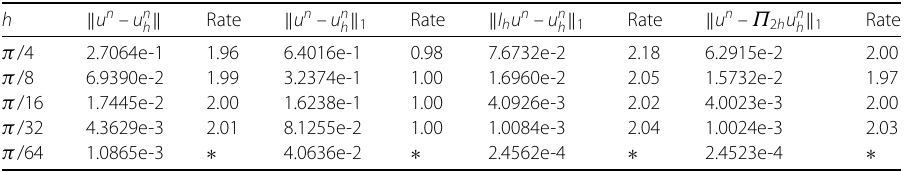
Table 6 Numerical errors and convergence orders in spatial direction with τ = 1 α = 0.3 at T = 1 for Example 2